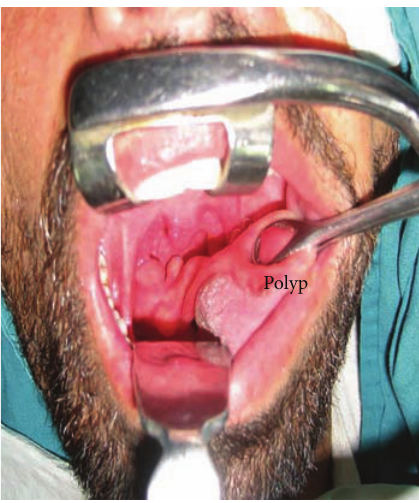
Figure 1: A large multilobulated polypoidal mass seen arising from the inferior pole of the right tonsillar fossa.